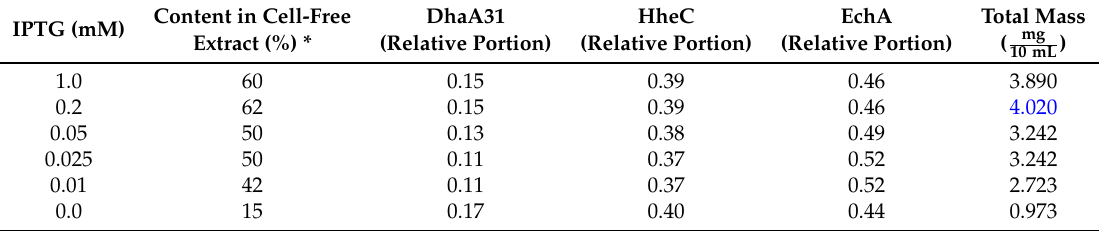
Table A2. Relative fractions of enzymes from Experiment 2.